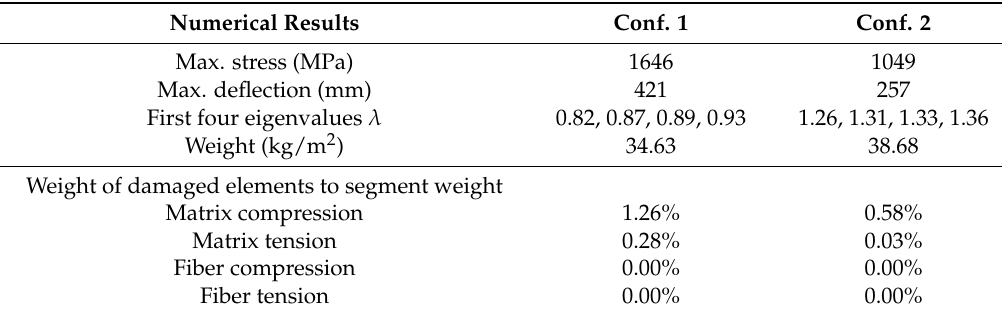
Table 3. Comparison between configurations 1 and 2.